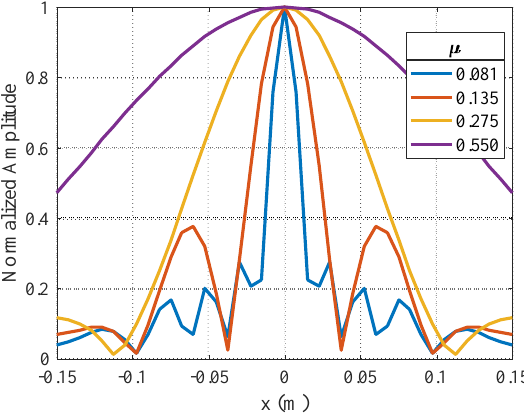
Figure 7. The point spread functions (PSFs) of four matrix H with different 𝜇 .